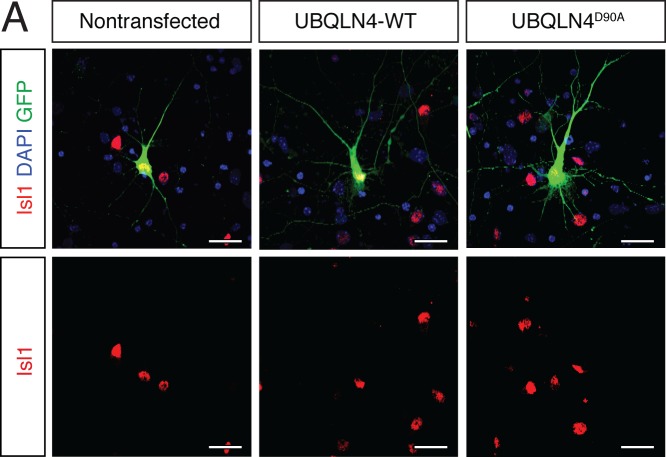
Cultured primary motor neurons express the motor neuron marker Islet1.(A) Representative images of primary mouse spinal cord neurons transfected with pCAG-GFP and UBQLN4-WT or UBQLN4D90A, stained with Islet1 (red) and DAPI (blue). Scale bar: 20 μm.